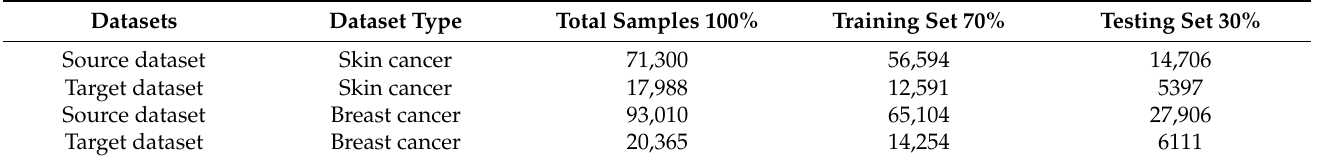
Table 4. Splitting the